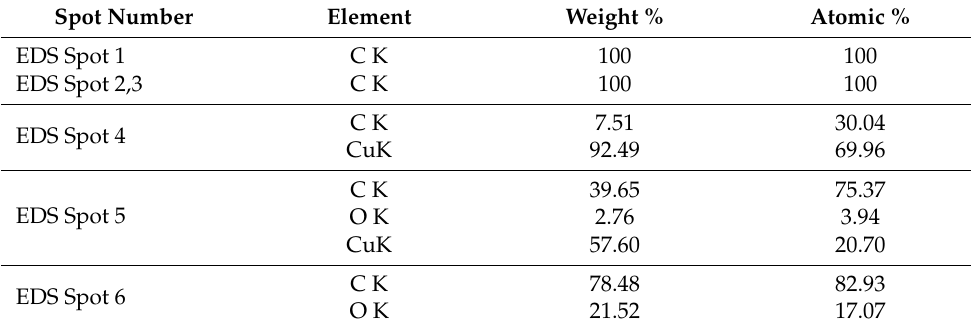
Table 2. EDX of Cu-Graphene powder mixture.